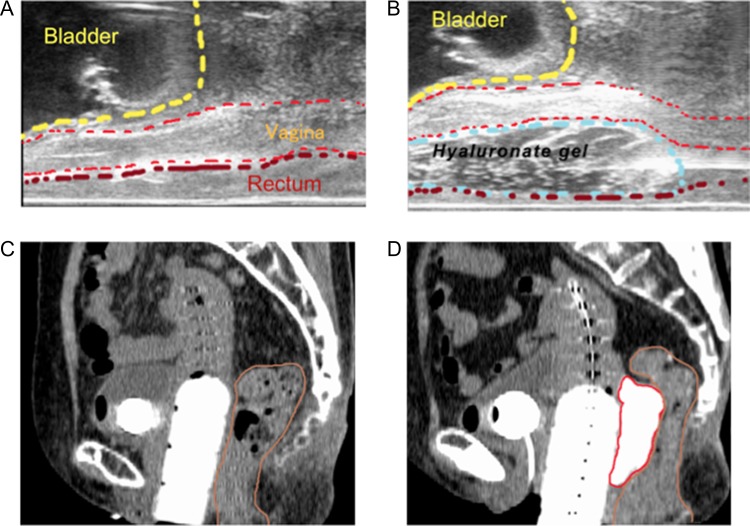
Hyaluronate gel injection (HGI) is performed under real-time transrectal ultrasound (TRUS) guidance. (A) Sagittal TRUS image obtained before HGI. (B) Sagittal TRUS image obtained during HGI. An application needle is inserted between the vagina and rectum via a transperineal approach, and hyaluronate gel is being injected into the pararectal space. Sagittal CT images before HGI (C) and after HGI (D) are also shown. The red line marks the hyaluronate gel and the brown line the rectum.